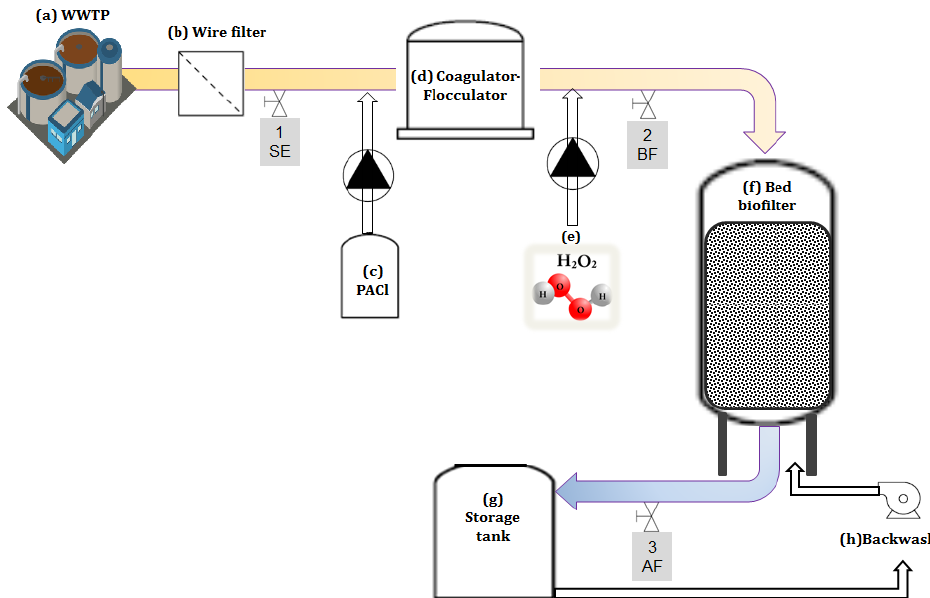
ffl uent from the Shafdan wastewater